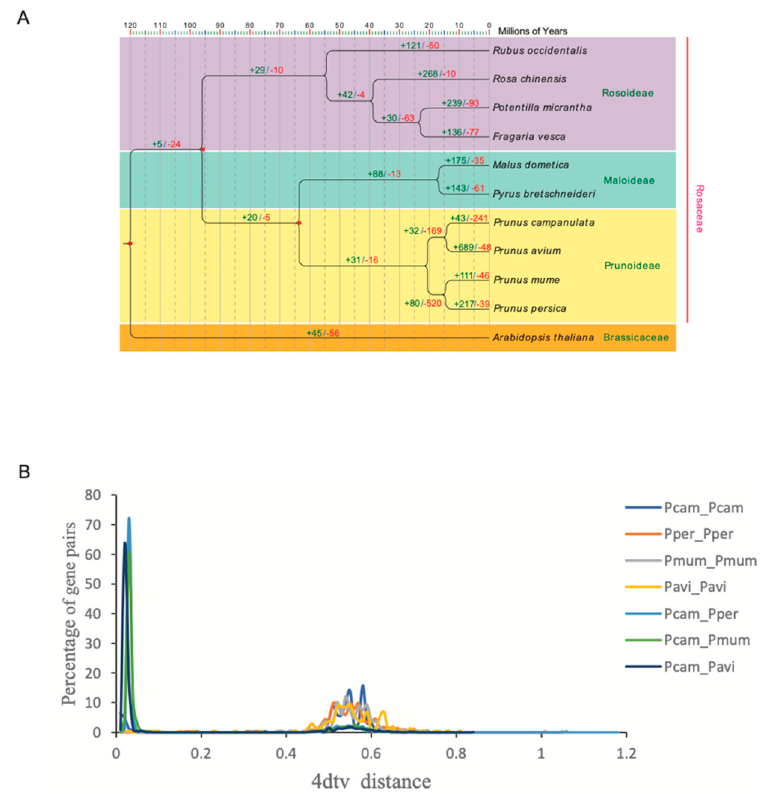
Figure 5. Evolution of the genome and gene families of P. campanulata . ( A ) Phylogenetic tree with the number of gene families displaying expansion and contraction from 11 species for estimating divergence time. The numbers on the branches show the expanded (green) and contracted (red) gene family numbers among all gene families. ( B ) Distribution of 4DTv values in Prunus species. Pcam: P. campanulata ; Pper: P. persica ; Pmum: P. mume ; Pavi: P. avium .